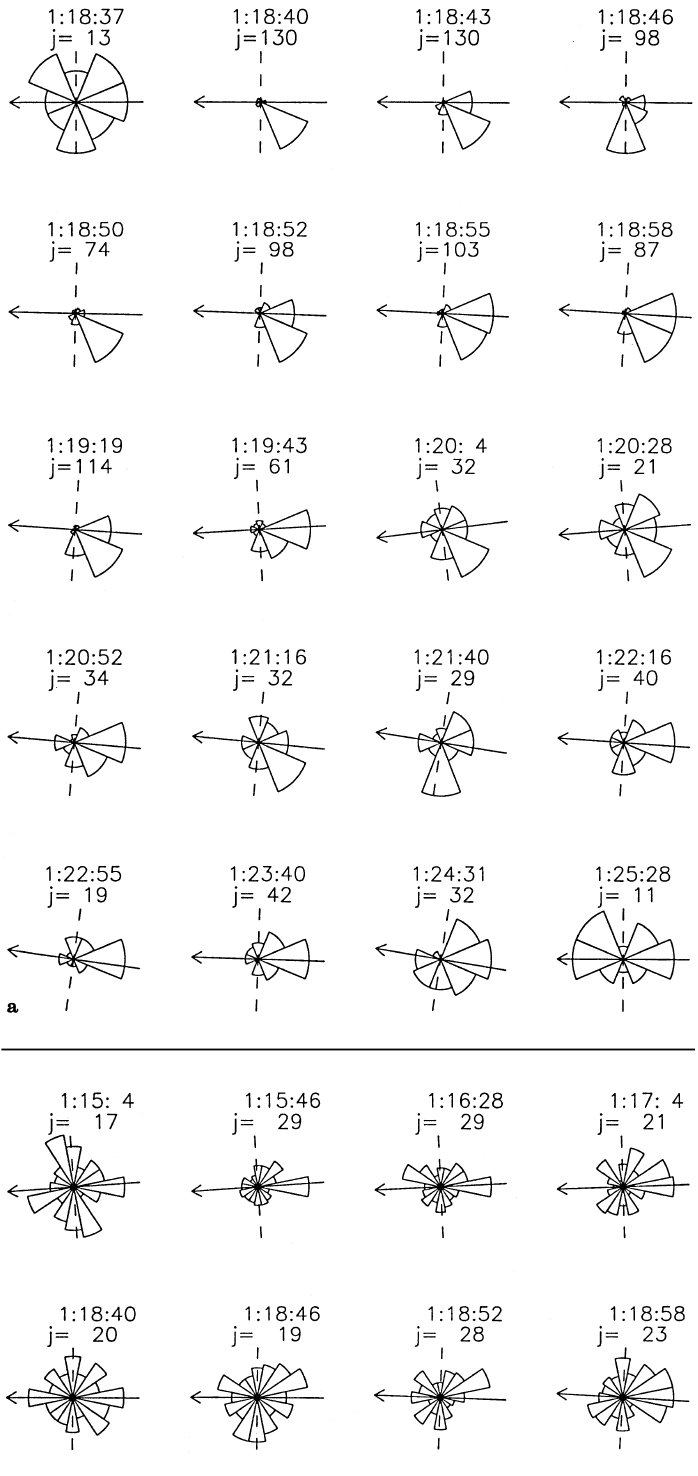
Fig. 6. a–d Angular distributions of energetic electrons with E > 38 keV in the ecliptic plane, during the BLP observed between 0115 UT and 0125 UT. The equatorial magnetic field projection is overplotted. The Sun lies to the left of the figure. b The angular distributions of 62–74 keV ions (mostly H + ), detected from channel E3, c the angular distributions of 74–89 keV ions (mostly H + ), detected from channel E4, and d the angular distributions of 89–110 keV ions (mostly H + ), detected from